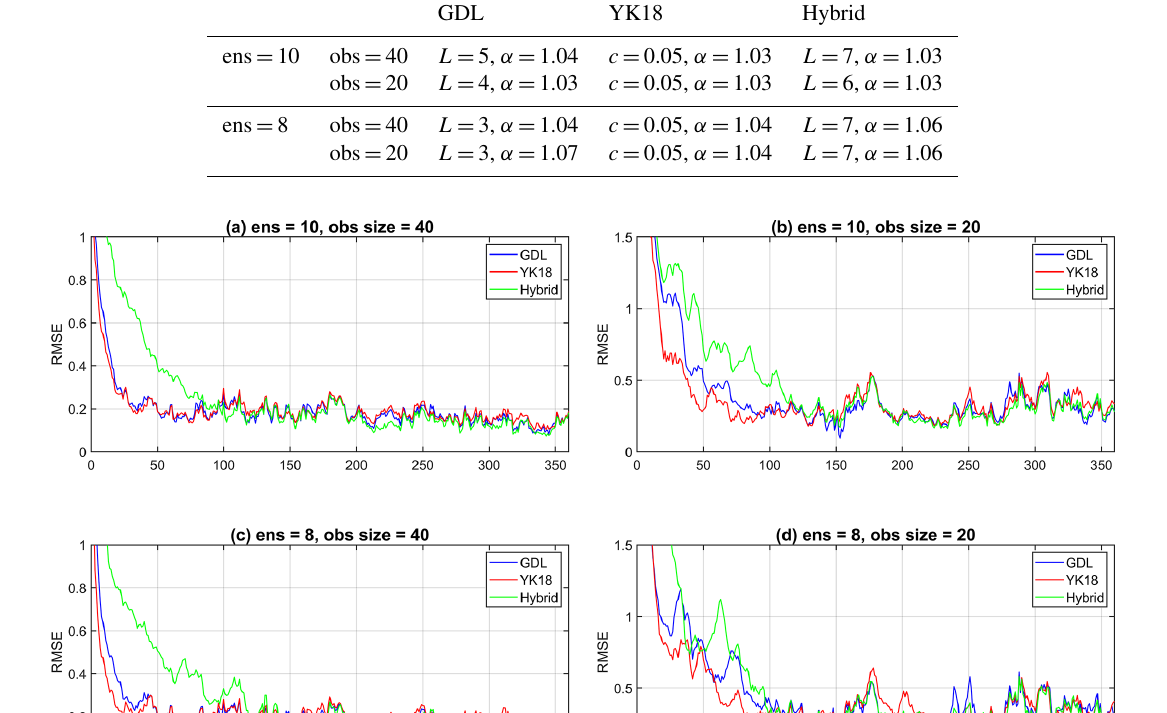
Table 1. The parameters used in the L96 model experiments given in Eqs. (4) and (7). The symbol α represents the multiplicative inflation parameter.